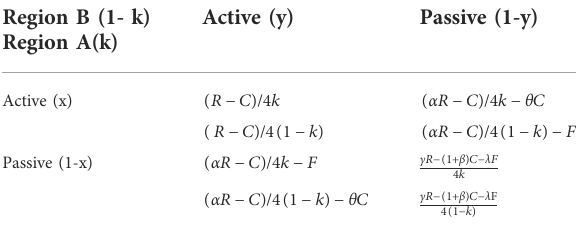
TABLE 7 Payment matrix of local governments in emergency cooperation. Region B (1- k) Region